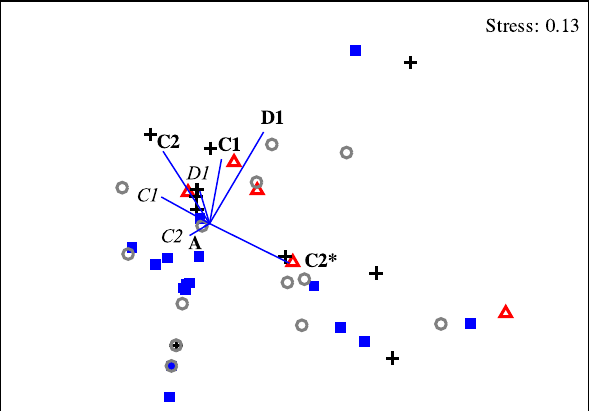
Figure 2. Two-dimensional MDS plot of the Symbiodinium community sampled at each of four regions on the Great Barrier Reef. Symbols: n Far Northern, + Northern, & Whitsundays, # Southern GBR. For symbiont types, bold indicates a dominant type and italics are those occurring at background levels.